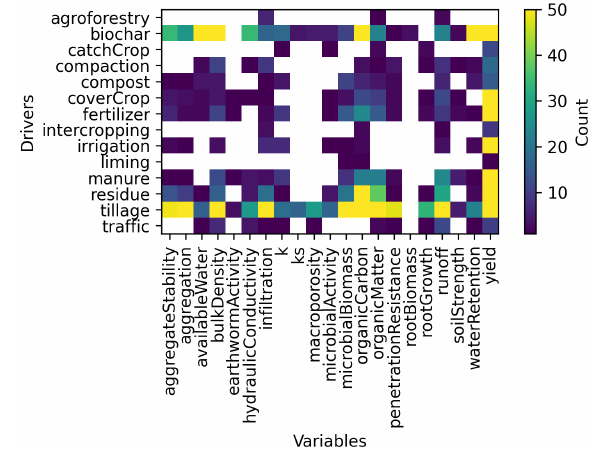
Figure 7. Number of relationships identified from abstracts accord- ing to the driver–variable pair they contain. White cells mean that no relationships were found for the pair inside. Results were obtained from the analysis on the Meta